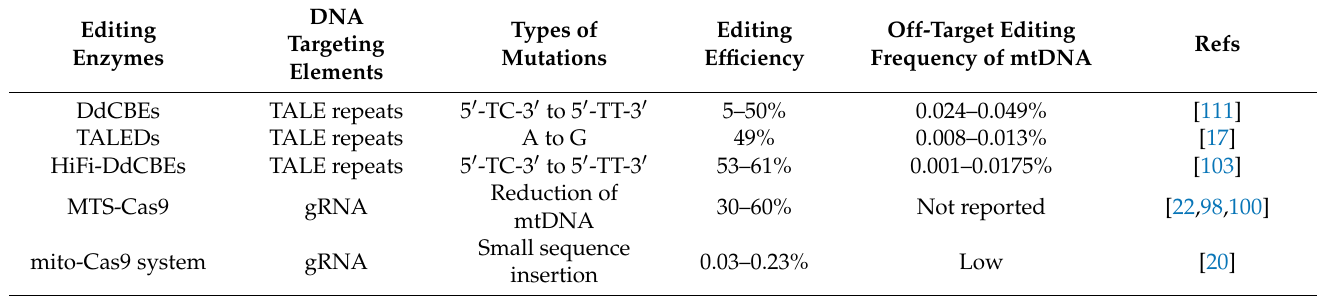
Table 1. A comparison of the latest targeted mitochondrial DNA-editing technologies in mammalian